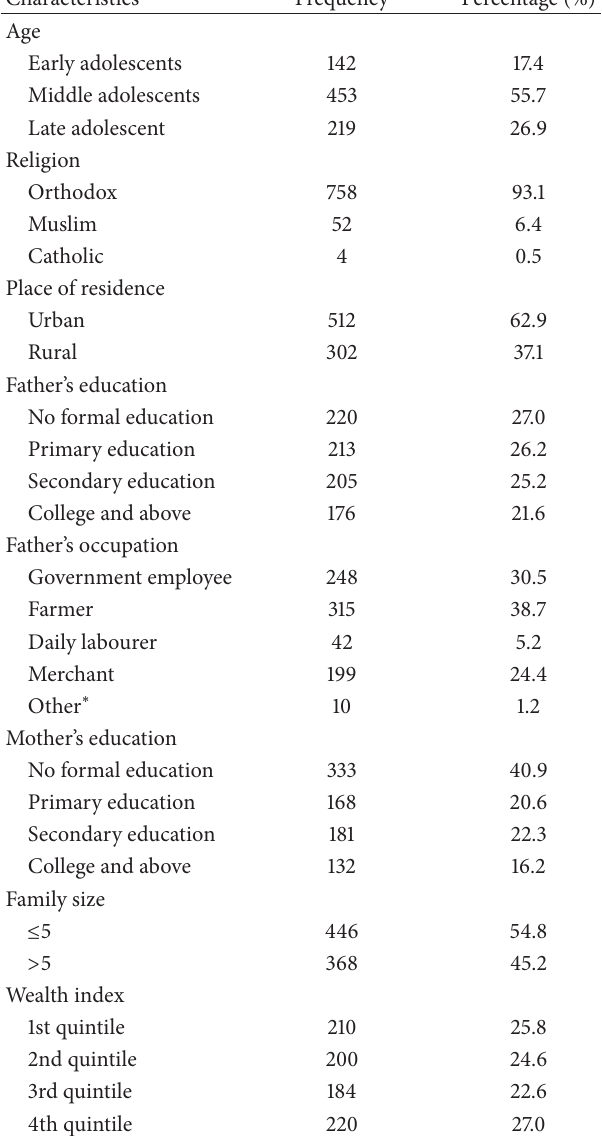
Table 1: Sociodemographic characteristics of adolescent school girls, Adwa town, Northern Ethiopia,